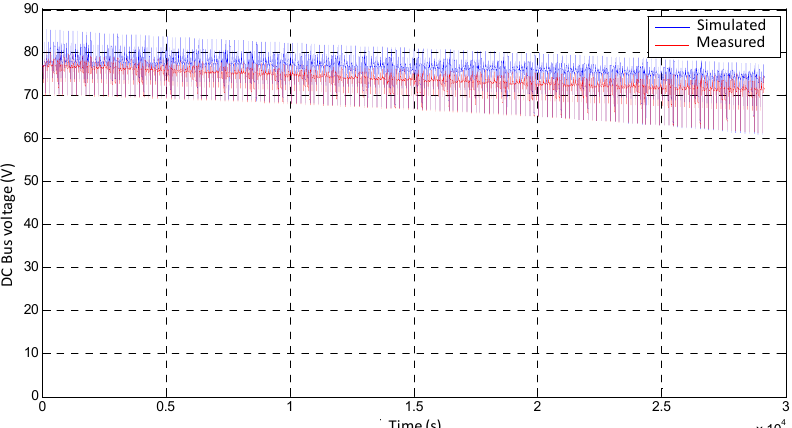
Figure 34. Experimentally measured and simulated DC bus voltage along the 8 h working day.